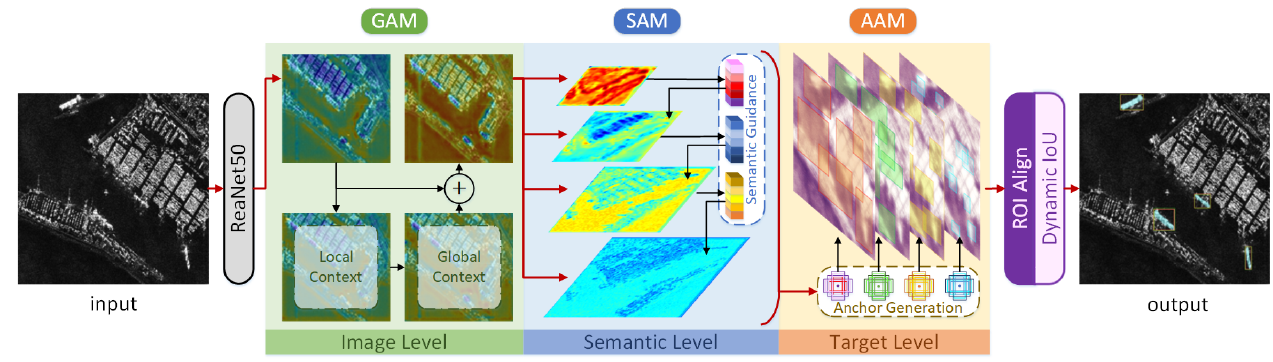
Figure 1. Overview of the proposed SA R-CNN: an overall synergistic attention design for instance segmentation which integrates three novel components: global attention module (GAM); semantic attention module (SAM) and anchor attention module (AAM), respectively, for the barriers in ship instance segmentation in SAR images at the image, semantic, and target